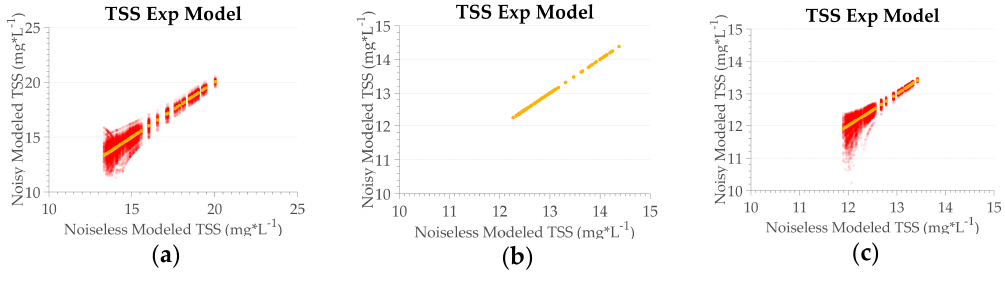
Figure 9. TSS_exp algorithm performance for TSS concentration. ( a ) MSI sensor; ( b ) OLCI sensor; ( c ) OLI sensor. Circles in red represent the data with noise, circles in yellow noiseless data. The transparency is based on the frequency distribution, in which opaque indicates a higher frequency, and transparent indicates a lower frequency.